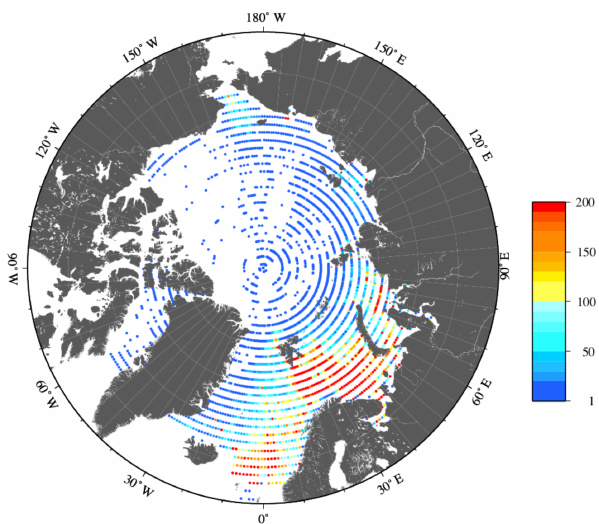
Figure 7. Data density of casts received through the GODAR